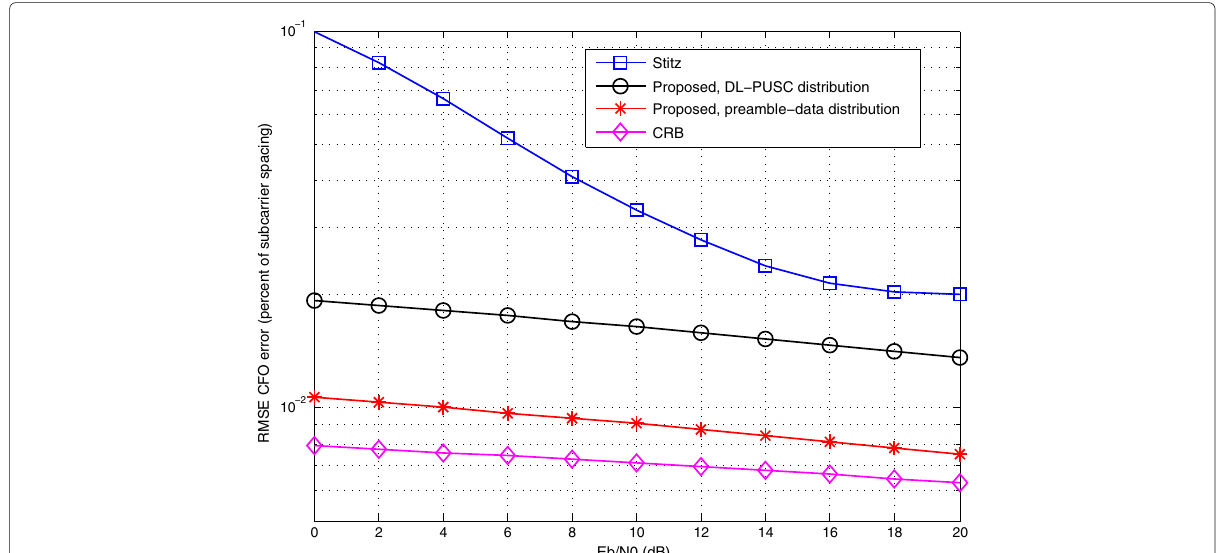
Fig. 4 Comparative RMSE error of CFO estimation versus input E b / N 0 with STO = 2.5% and Rayleigh